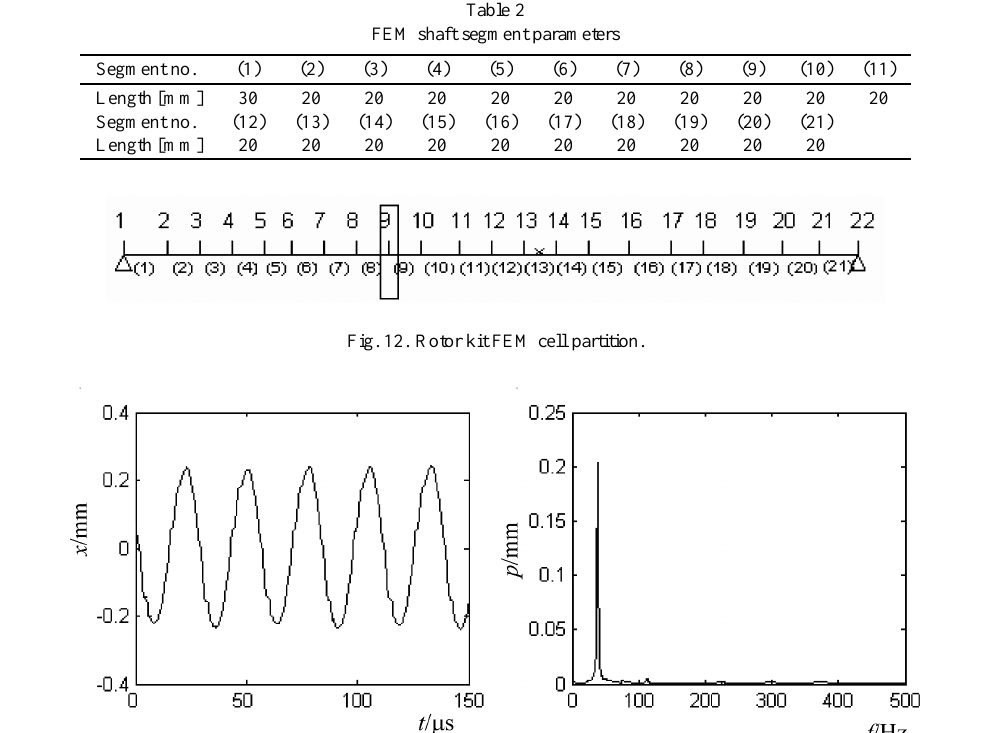
Fig. 13. The waveform and spectrum of cracked